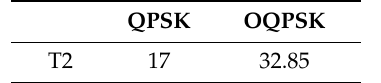
Table 4. Theoretical values of T2 for QPSK and